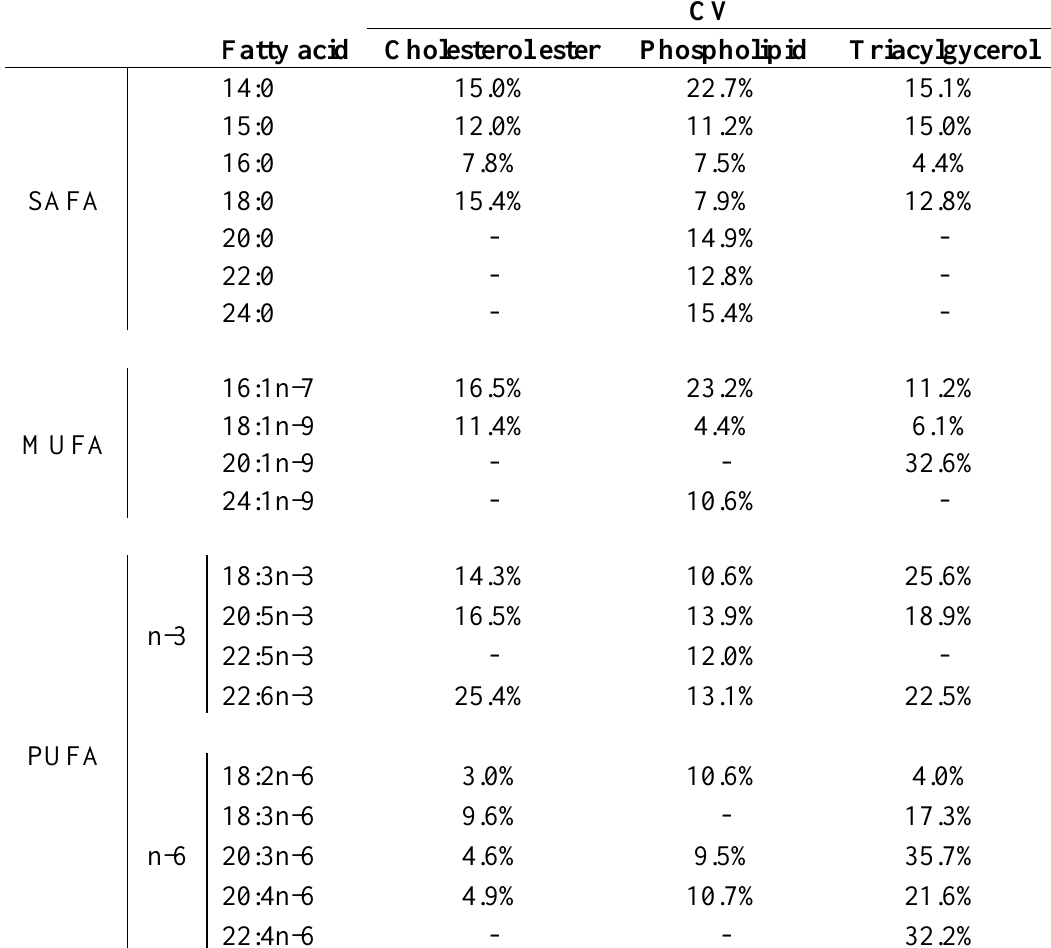
Table 1. Coefficients of Variation (CVs) for the serum fatty acid